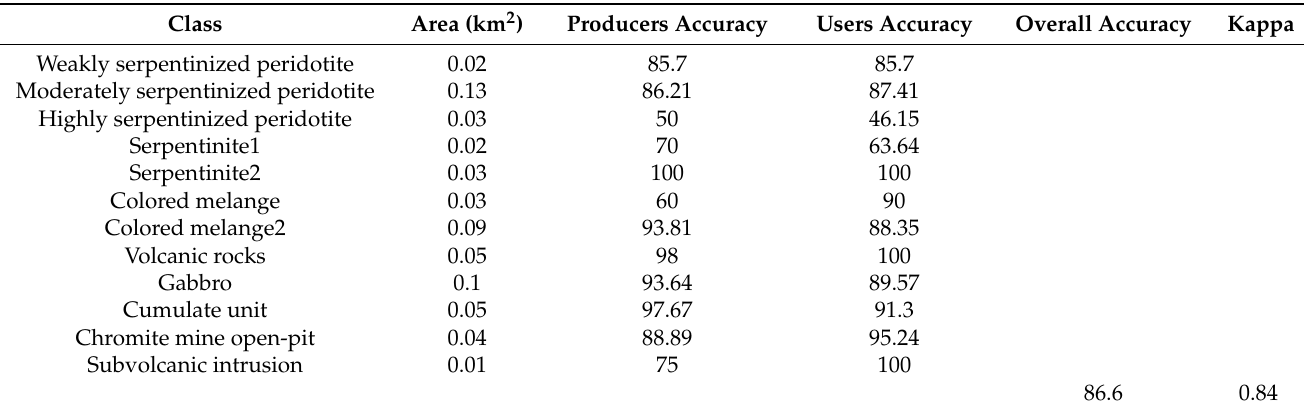
Table 2. The main results of accuracy assessment using confusion matrix for the lithological classifi- cation produced by SVM method on ASTER image (The full results are included in the supplemen- tary